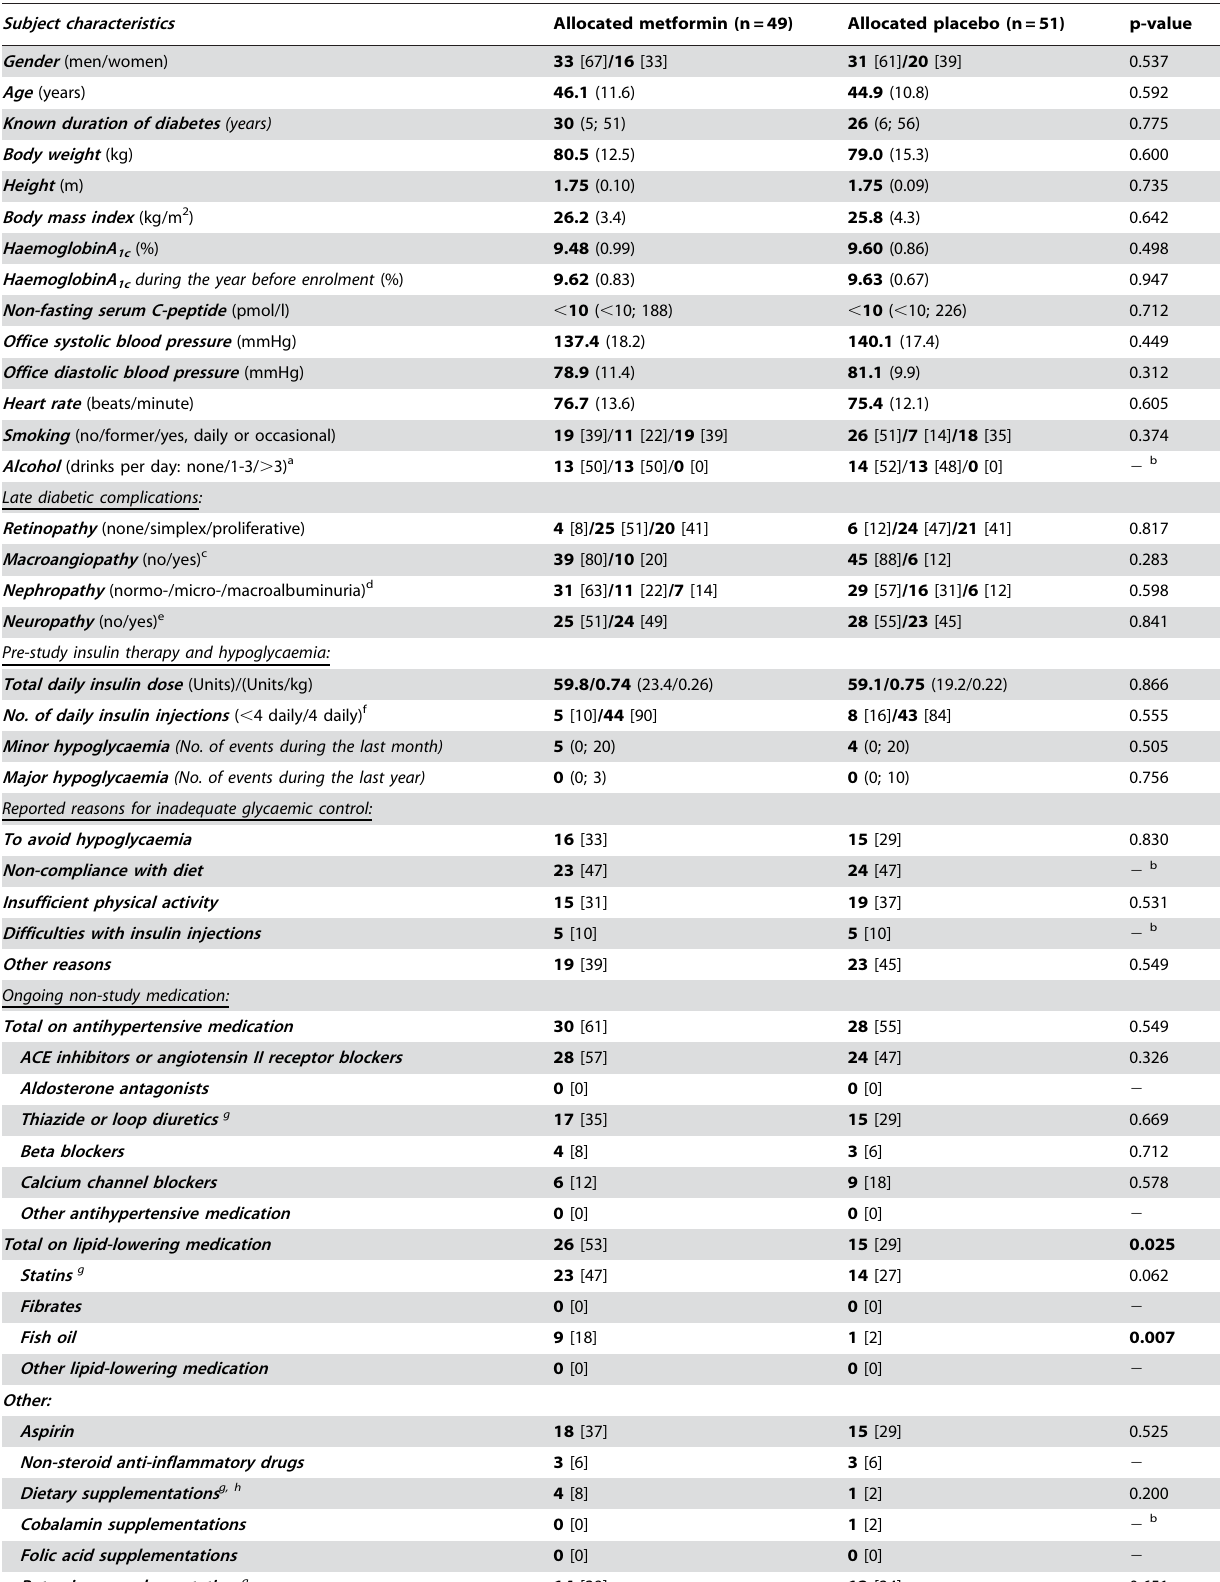
Table 2. Subject characteristics at enrolment ( 2 1 month) for 100 patients with type-1